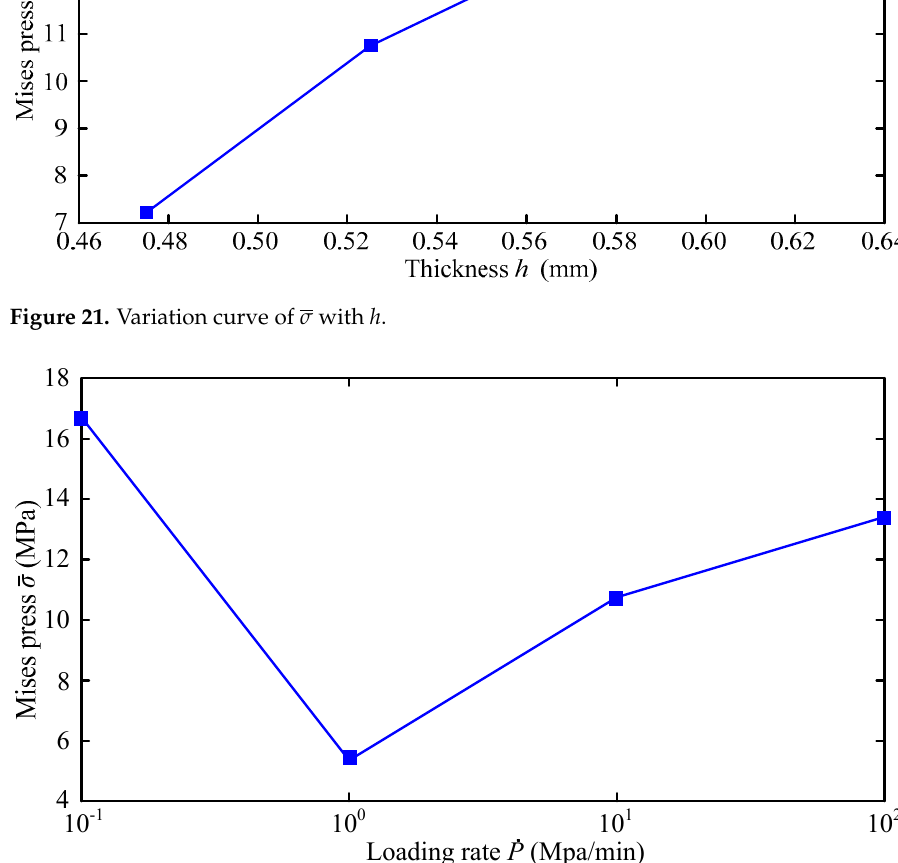
Figure 22. Variation curve of 𝜎 with loading rate.